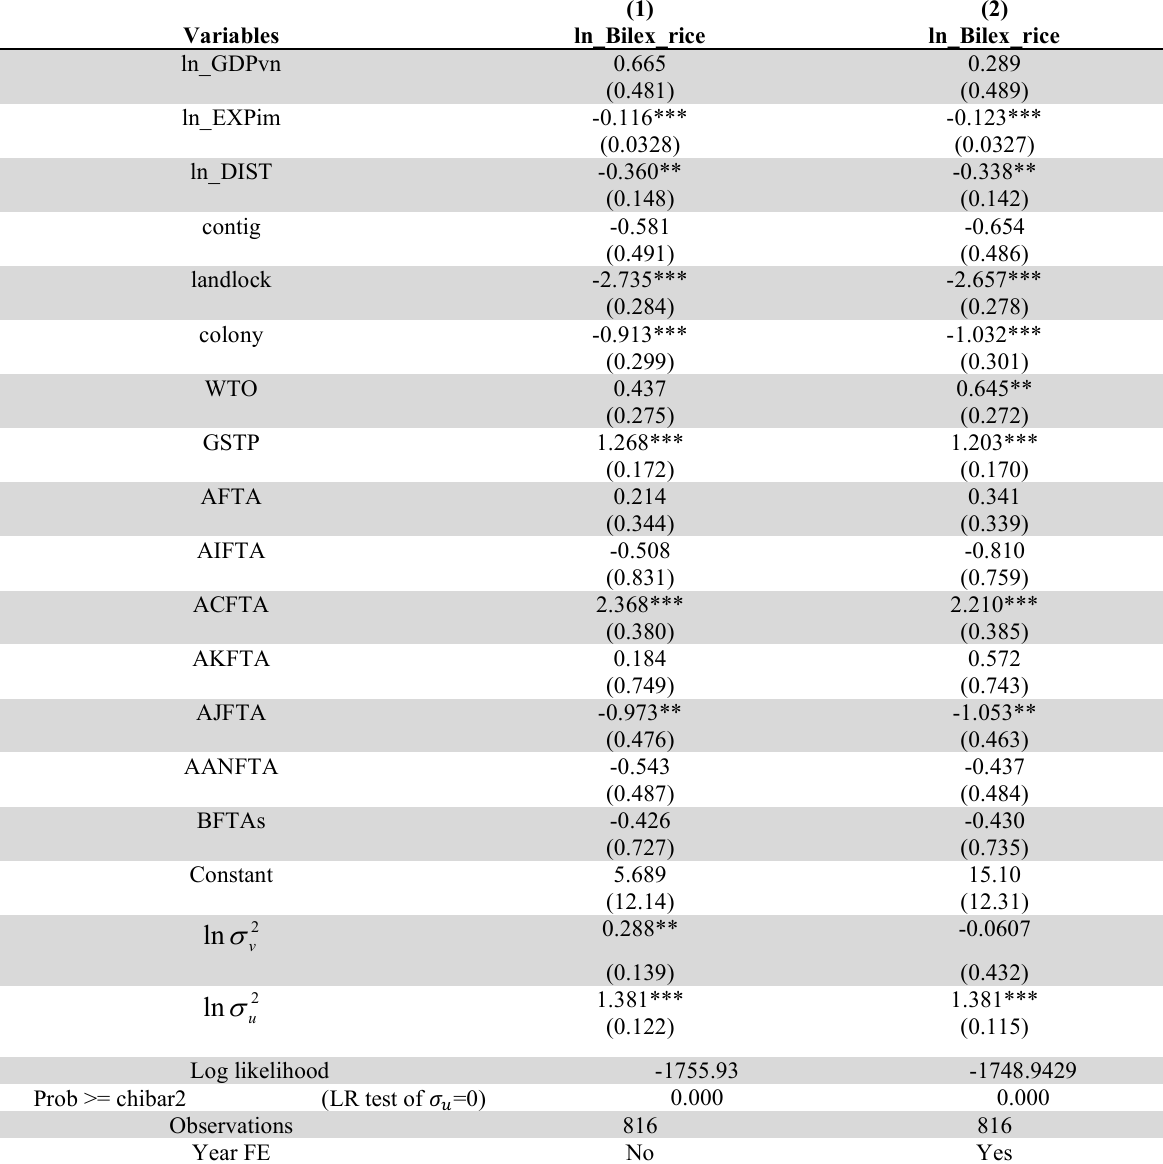
Estimated results with the assumption u i follow the rule of exponential